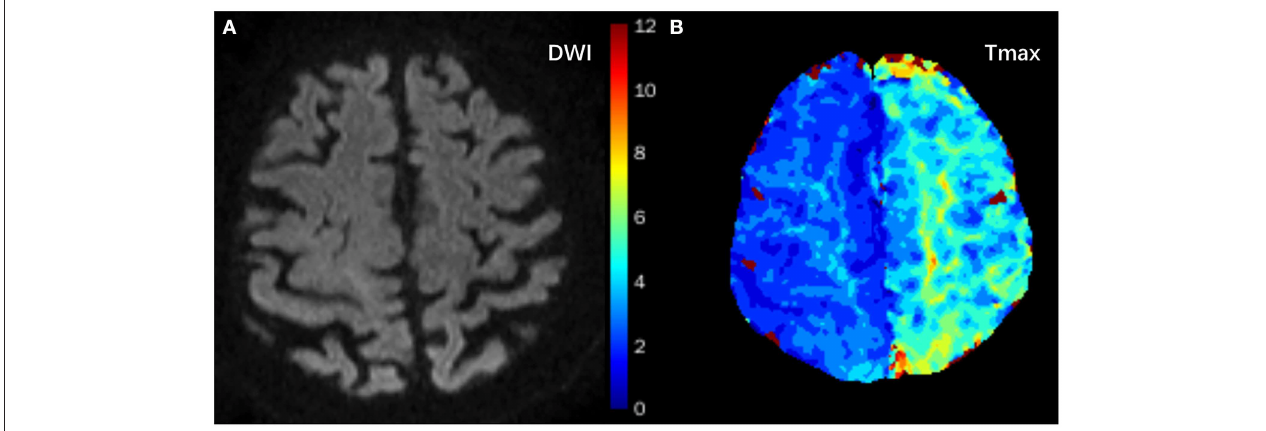
FIGURE 1 | Typical images of an 84-year old female with a history of hypertension who presented with right upper limb paresis three times within 4h. It lasted 2min each time. DWI showed negative findings of strokes (A) , but T max showed focal hypoperfusion areas in the left frontal and parietal lobes ( B , green areas).